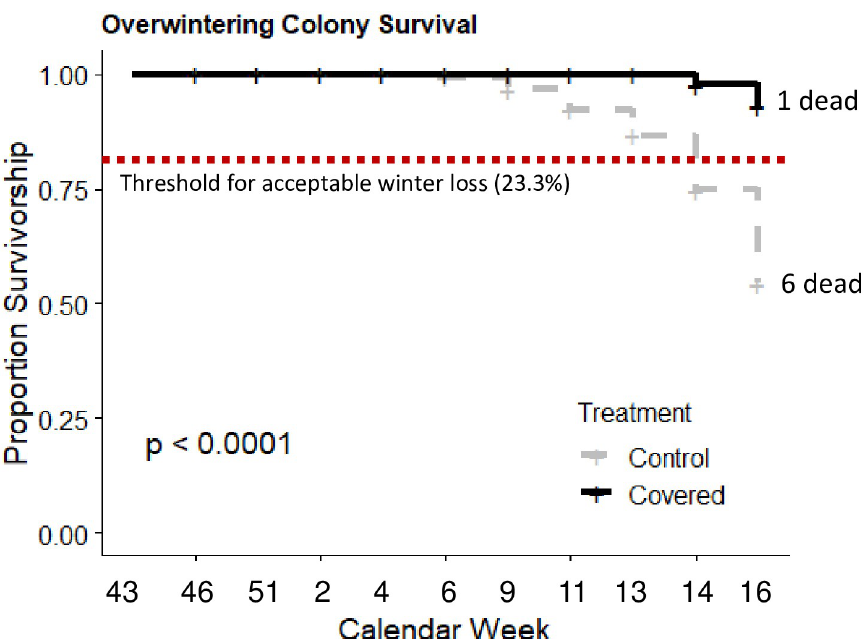
Fig 6. Proportion survivorship of colonies by treatment (covered vs control). Survivorship was significantly higher for colonies that were wrapped compared to those that were left unwrapped.